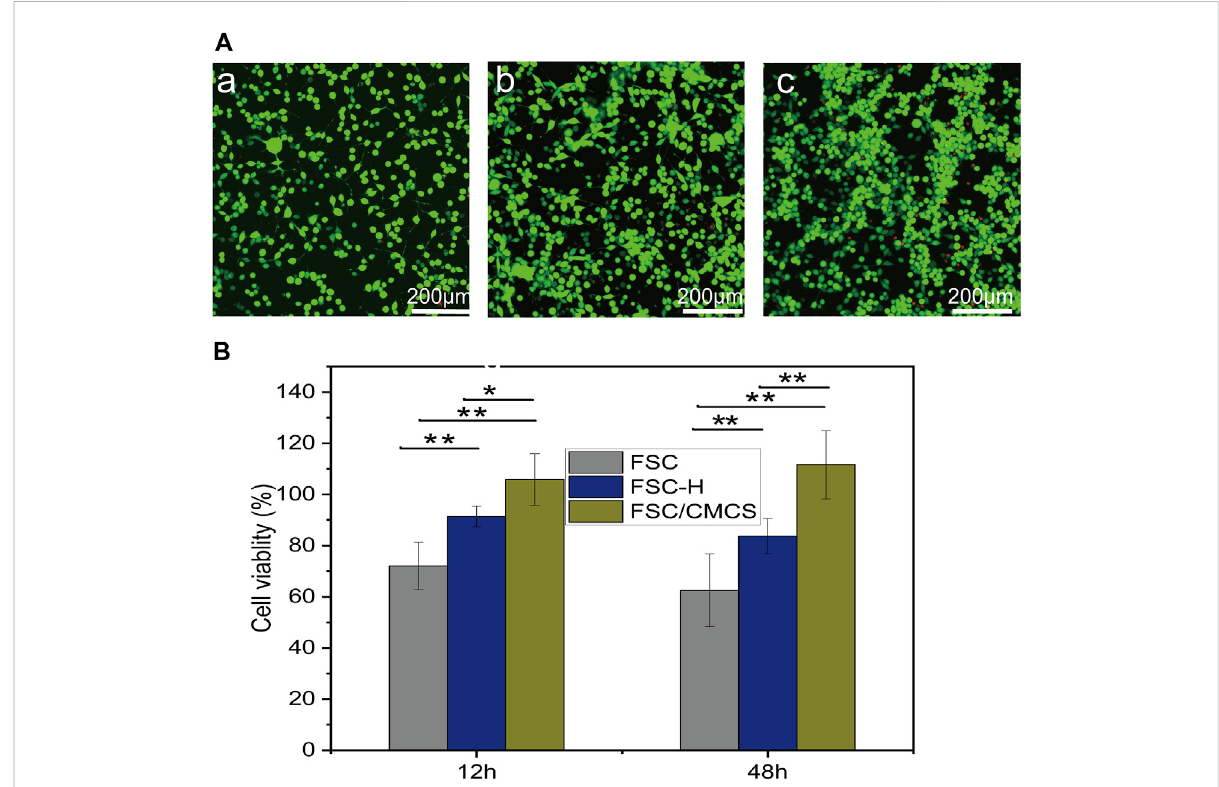
FIGURE 6 CytotoxicityassaysofL929murine fi broblastcellsupontreatmentwithbasicDMEM. (A) GrowthofL929cellstreatedon (a) FSC, (b) FSC-H,and (c) FSC/CMCS membranes. (B) Cytotoxicity of L929 cells after 12 and 48 h of contact with leaching liquors obtained from the FSC, FSC-H, and FSC/ CMCS membranes. Live cells stained with Calcein-AM dye produced an intense uniform green fl uorescence. Dead cells stained with EthD-I